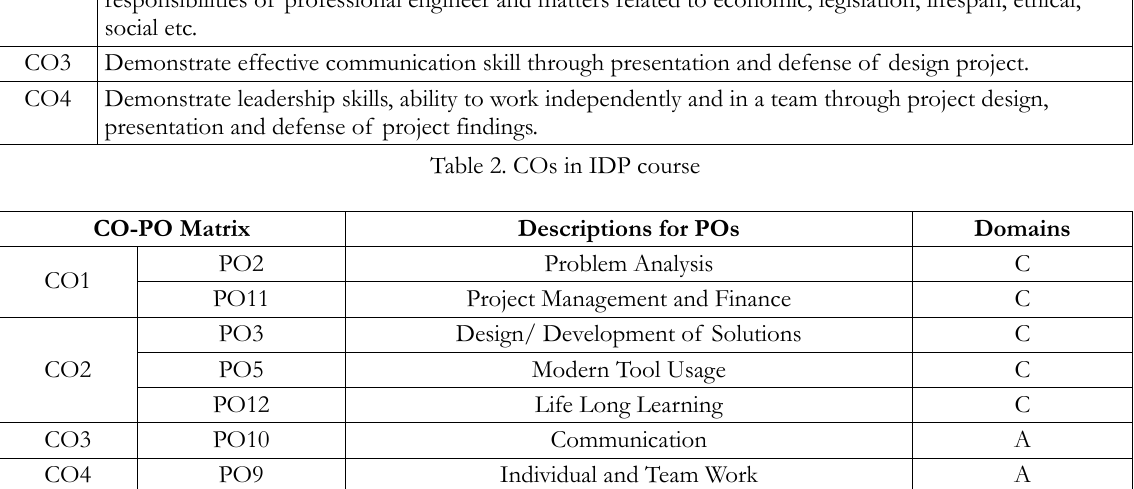
Table 3. CO-PO Matrix for